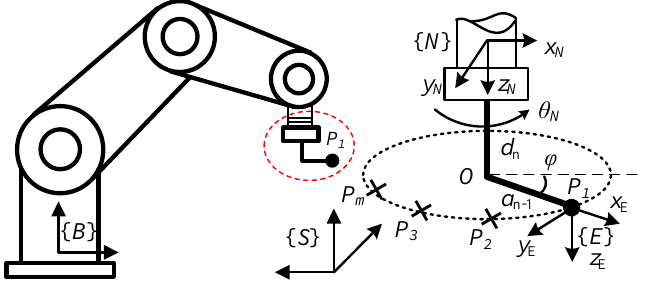
Figure 1. Basic principle of the measurement